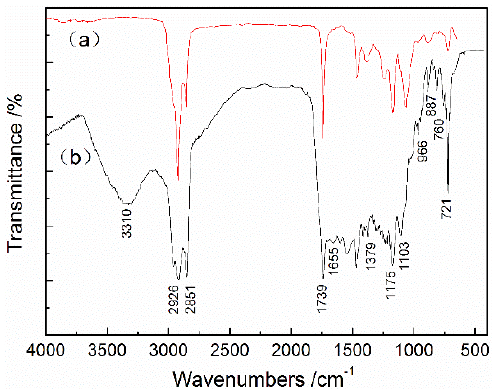
Figure 11. FTIR spectra of ( a ) butyl stearate and ( b ) MicroPCMs.